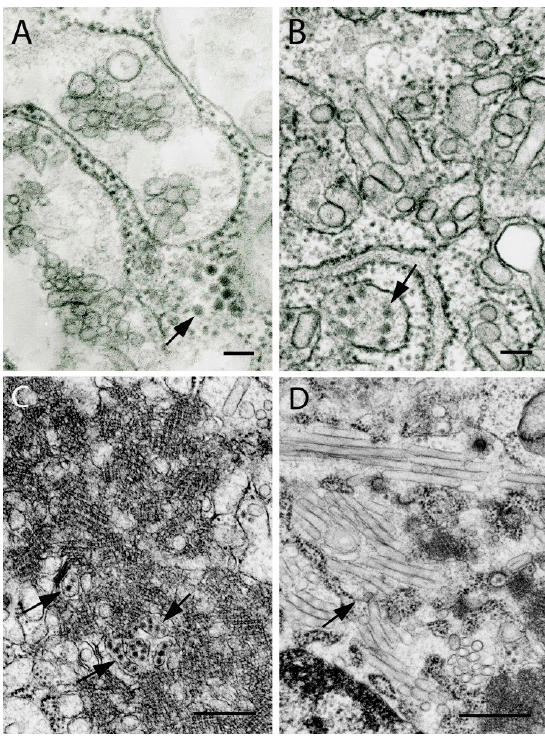
Figure 5. Ultrastructure of flaviviruses (genus Flavivirus , family Flaviviridae ). ( A ) Dengue virus (strain DKE-121). Virions ~40 nm in diameter (arrow) and mostly circular smooth membrane structures (SMS, 25–100 nm in diameter) inside expanded cisterns of granular endoplasmic reticulum (ER). Bar = 100 nm. ( B ) Hu 4578-07 virus (unassigned; probable genus Flavivirus ). Virions (arrow) and abundant SMS, 50–65 nm in diameter and up to 375 nm long, inside ER. Bar = 100 nm. ( C ) Hu 4578-07 virus. Virions (arrows) inside ER, abundant convoluted membranes. Bar = 0.5 µ m. ( D )